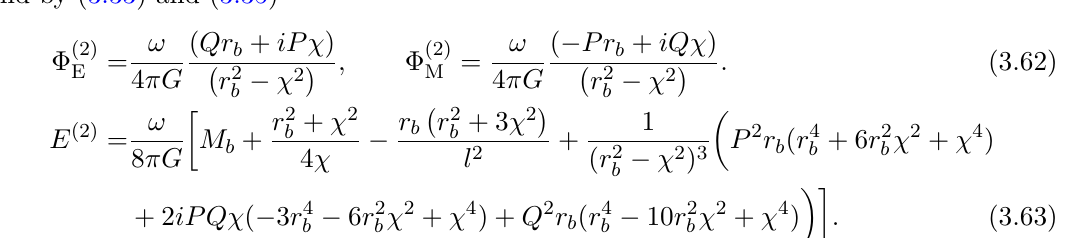
Figure 6 . Heat capacity (3.58) for TB-AdS for κ = 1 vs. χ for fixed Q and g with G = l = 1 . and by (3.33) and